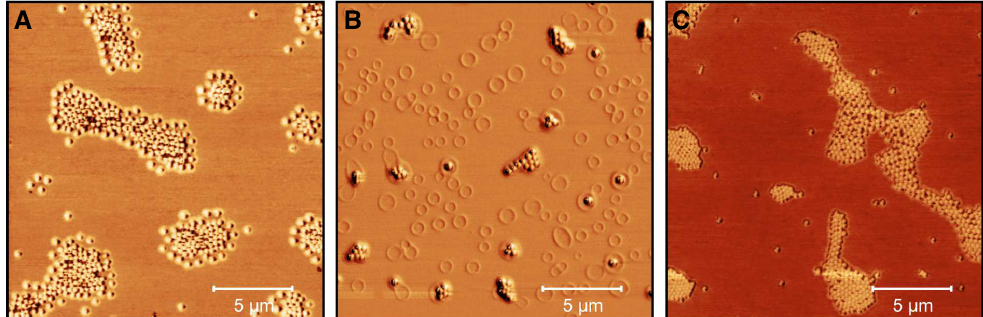
Figure 10. AFM phase images (20 × 20 µ m) of microgel particles in water ( A ), microgel particles in ethanol/CBD solution ( c CBD = 25mg/mL) ( B ) and after the release of CBD in ethanol at 40°C (with removed supernatant and redispersion in ethanol) ( C ). The images were recorded at room temperature in the dried state on PEI coated silicon